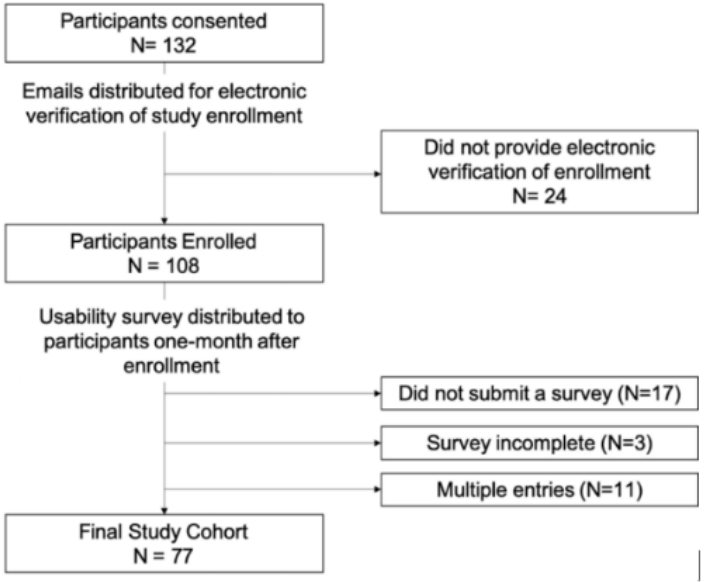
Figure 2. Study flow diagram.